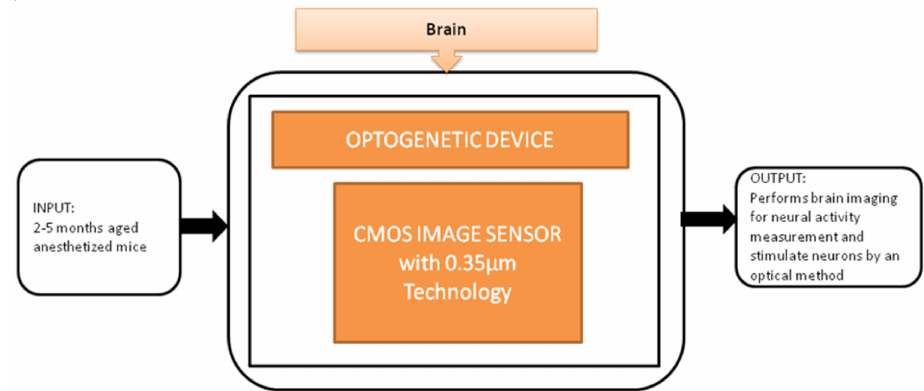
Figure 20. Implantable optogenetic device.